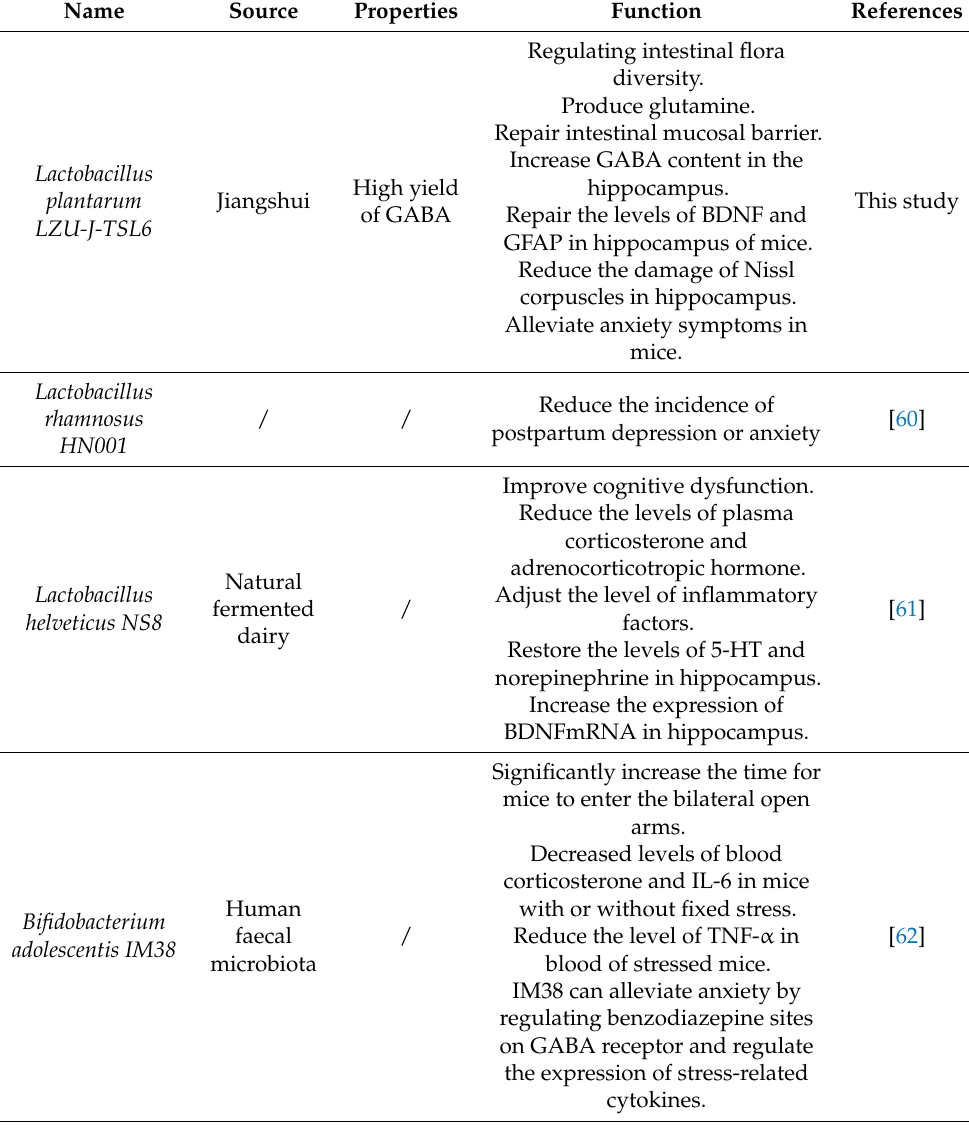
Table 3. Comparison of obtained results in anxiety upon the use of Lactiplantibacillus plantarum LZU-J-TSL6 and probiotics reported in previous